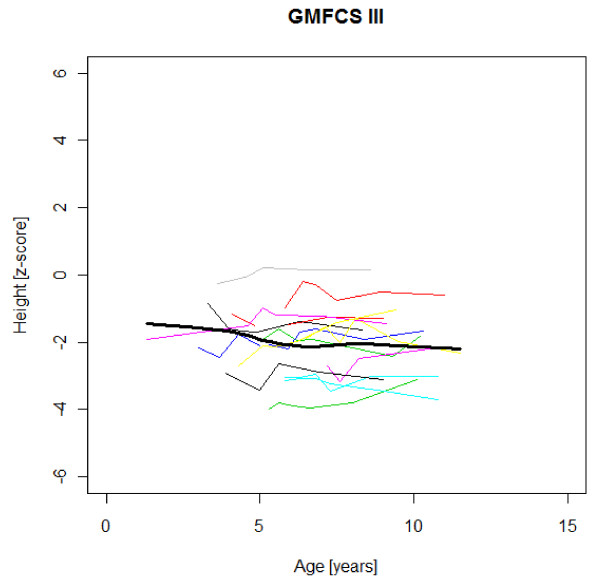
Height z-scores in GMFCS III. Height z-score at different age in 15 children with CP spastic diplegia, GMFCS III. Their mean z-score development with age is shown in black.